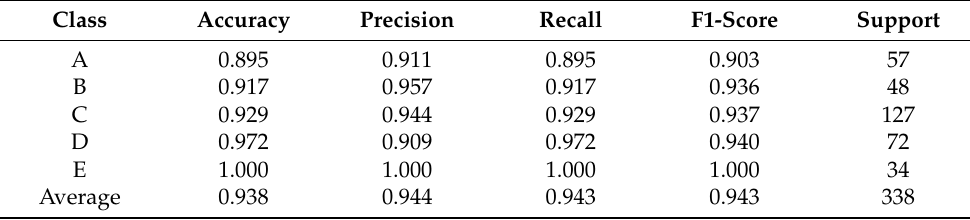
Table 7. The results of each class on Dataset